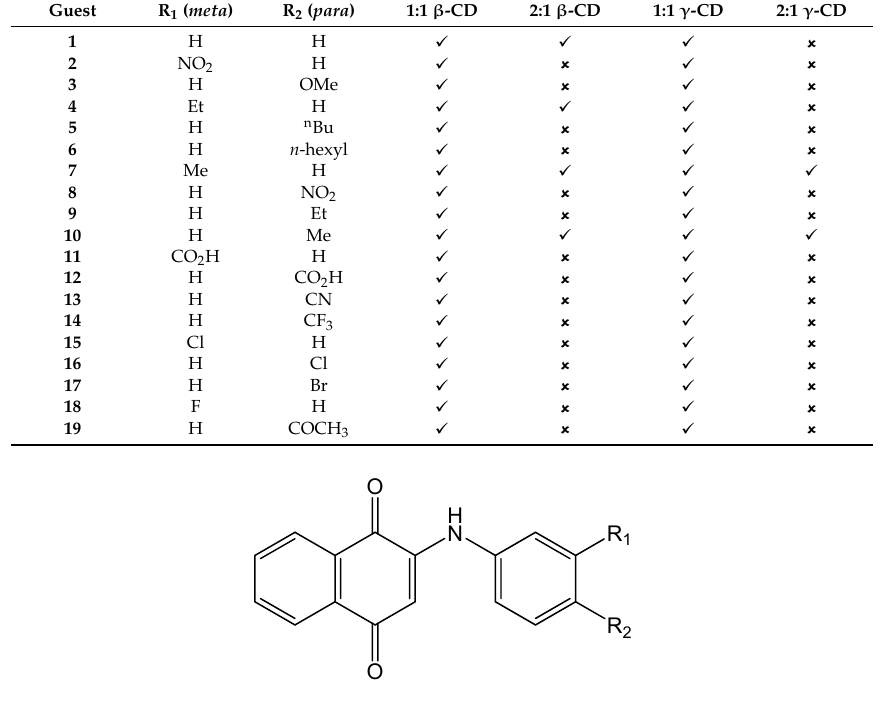
Table 1. Substituents and substitution pattern for 2-[(R-phenyl)amine]-1,4-naphthalenedione (PAN) derivatives 1 – 19 , and their CD:PAN complex stoichiometries as observed by MS-ESI spectrometry.